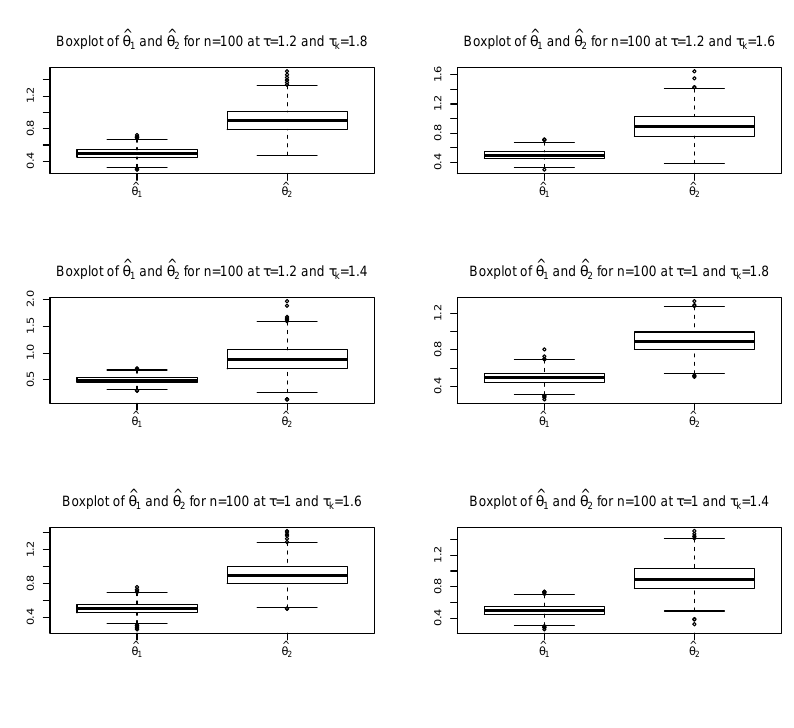
b θ b θ Figure 1 – Boxplots of 1 and 2 for 1000 simulations 5. Using the values of n 1 , n 2 , τ , τ k and the ordered observations obtained in step 4, ML estimates of θ 1 and θ 2 is obtained by solving equations (11) and (12) using Newton-Raphson algorithm. Newton-Raphson algorithm is implemented by using maxLik package in